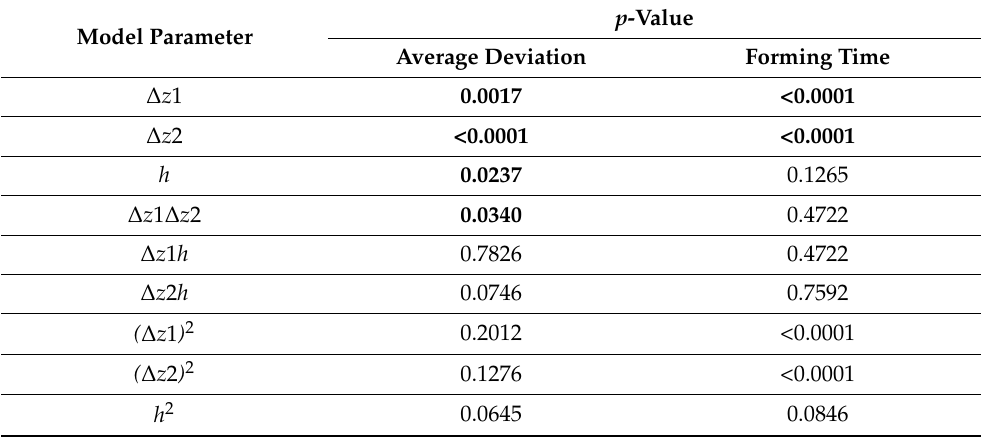
Table 4. The p -values of the individual parameters and the interactions for the two outputs. Model